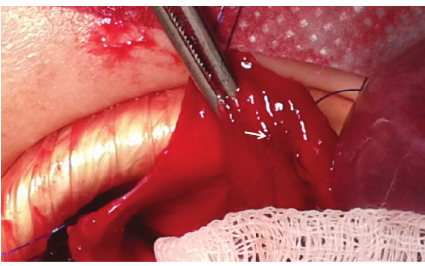
Figure 2: A spurting arterial vessel was seen after gastrotomy (white